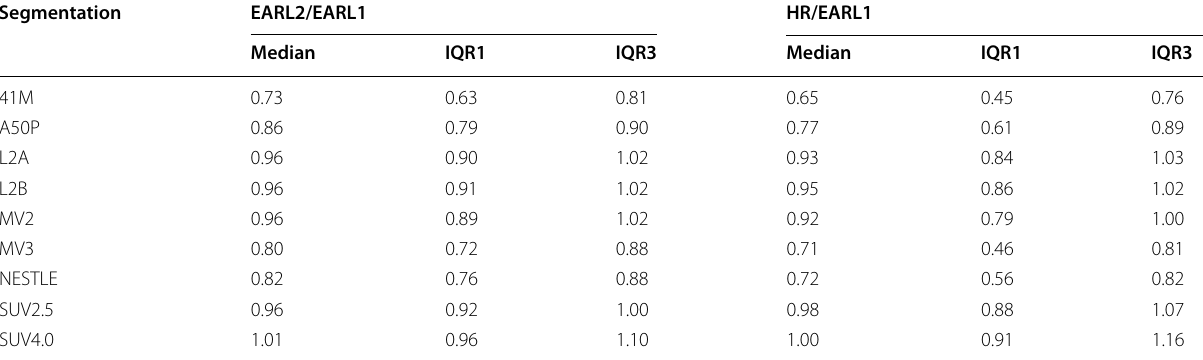
Table 3 MTV ratios (median and IQR for each segmentation method) for EARL2 and HR reconstructions Segmentation